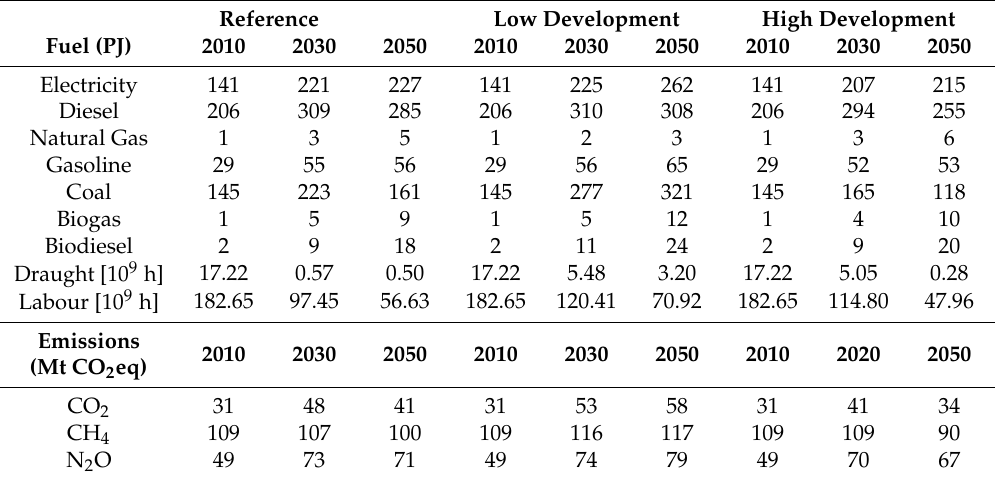
Table 13. Fuel use and emissions for reference, low and high development